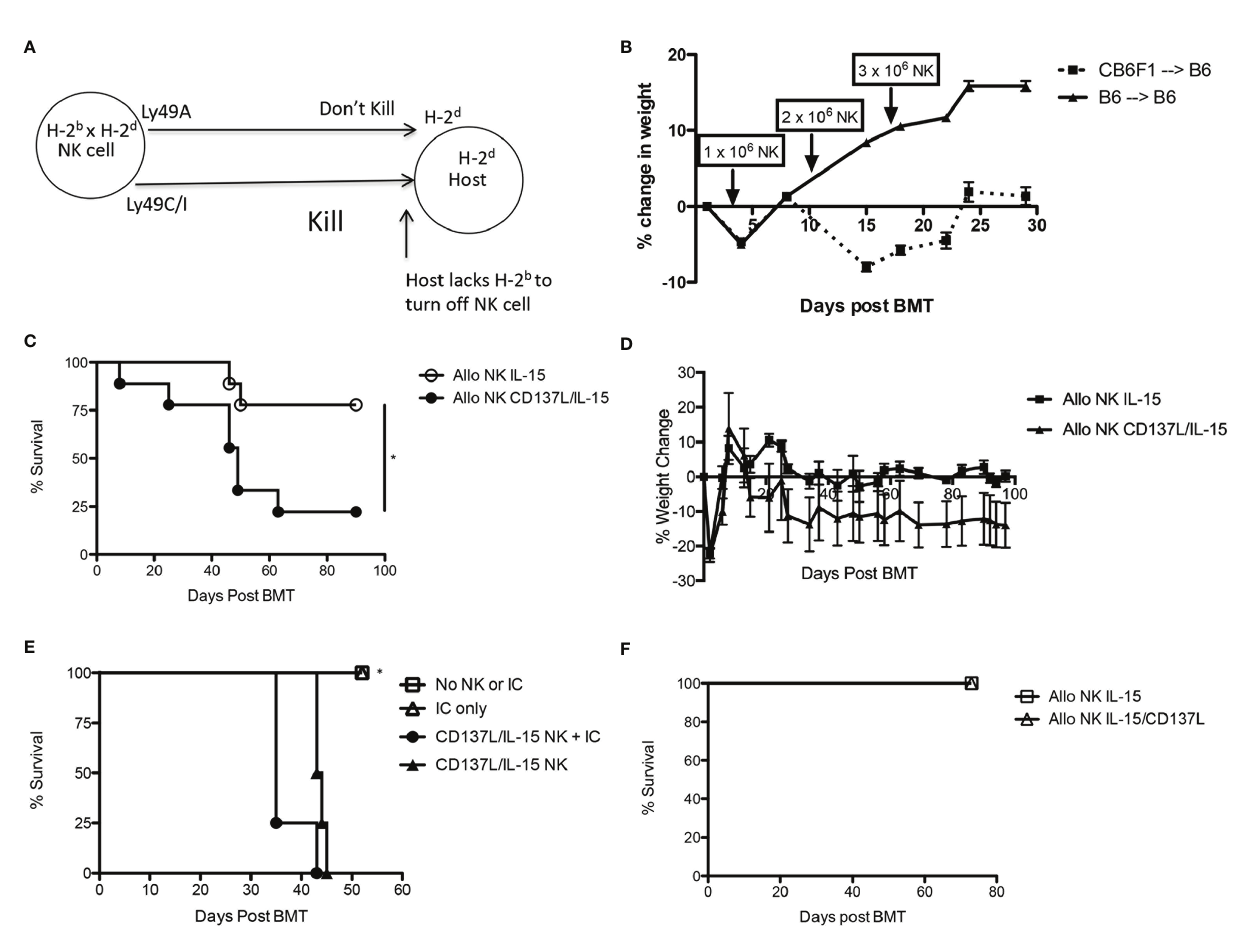
FIGURE 4 | Effects of ex vivo expanded NK cells after syngeneic and allogeneic MHC-matched and mismatched HSCT. (A) Child into parent HSCT schema showing how “ missing self ” in host prevents engagement of Ly49 inhibitory receptors on donor NK cells. (B) Lethally irradiated B6 mice (H-2 b ) were transplanted with CD3e cell depleted BM from B6 (H-2 b ) or CB6F1 mice (H-2 bxd ) on Day +0. On Days +3, +10, and +17 HSCT recipients received donor-derived, CD137L/IL-15/IL-15R a expanded NK cells in increasing dose increments of 1, 2 or 3 x 10 6 cells, and were followed for weight loss and survival. N=5 mice/group. (C) Lethally irradiated Balb/c mice (H-2 d ) were transplanted with CD3e cell depleted BM from CB6F1 mice (H-2 b x d ) on Day +0. On Day +1 HSCT recipients received 5 x 10 6 CB6F1 NK cells (H-2bxd) cultured in IL-15 alone, or activated with CD137L/IL-15/IL-15R a , and were followed for survival and (D) weight loss. Lethally irradiated Balb/c mice (H-2 d ) were transplanted with CD3e cell depleted BM from CB6F1 mice (H-2 b x d ) on Day +0. On Day +1 HSCT recipients received 5 x 10 6 CB6F1 NK cells (H-2 bxd ) cultured in IL-15 alone, or activated with CD137L/IL-15/IL-15R a , and were followed for survival. Results pooled from 2 separate experiments, 9 mice/group. (E) Lethally irradiated A/J mice (H-2 a ) were transplanted with CD3e cell depleted BM from B6 mice (H-2 b ) on Day +0. On Days +14-16, PBS (No IC) or hu14.18-IL-2 (IC) was administered. On Day +16, select groups were infused with 2.5 x 10 6 CD137L/IL-15/IL-15R a expanded B6 NK cells and followed for survival. N= 5 mice/group. (F) Lethally irradiated Balb/c mice (H-2 d ) were transplanted with CD3e cell depleted BM from DBA mice (H-2 d ) on Day +0. On Day +1 HSCT recipients received 5 x 10 6 CB6F1 NK cells (H-2 b x d ) cultured in IL-15/IL-15R a alone, or activated with CD137L/IL-15/IL-15R a , and were followed for weight loss and survival. N=5 mice/group. *p <